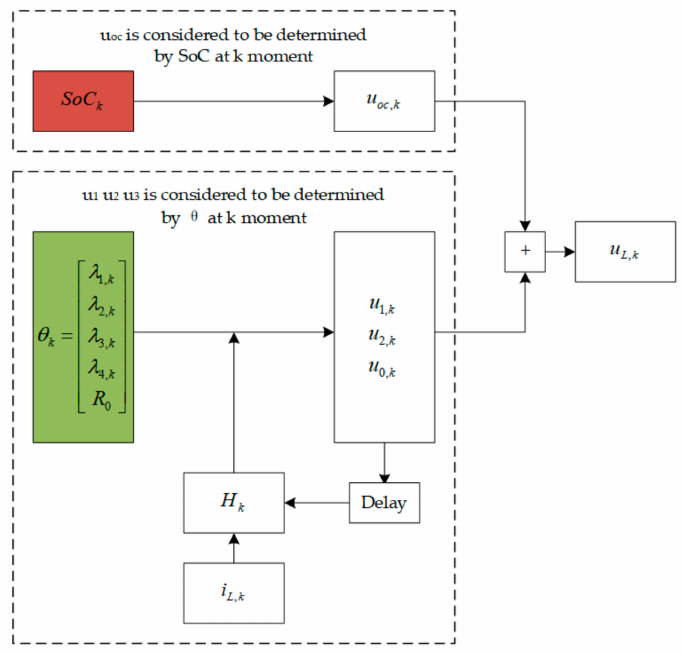
Figure 3. Structure of the state-parameter separated